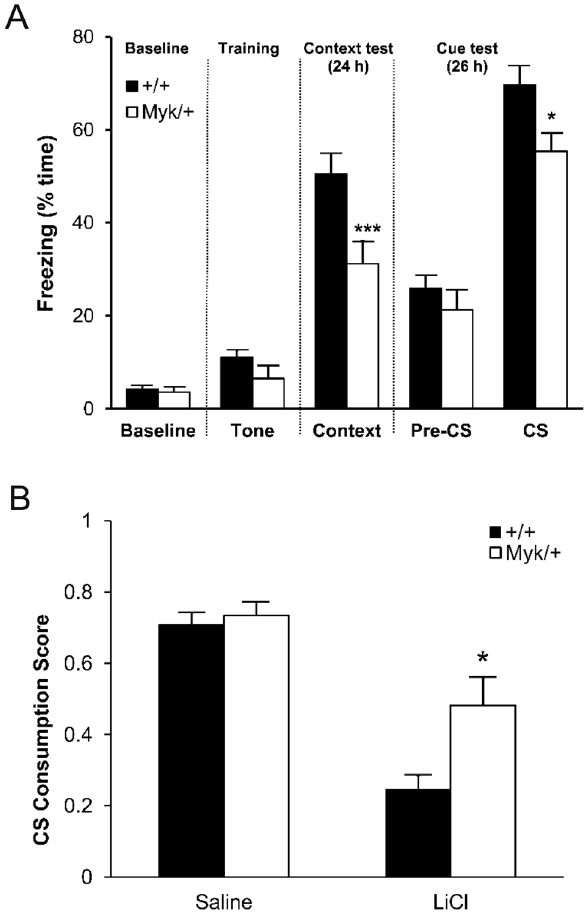
Figure 3. Cognitive impairment in Myk / + mice. (A) Fear conditioning with 1.0-mA footshock. Mean freezing levels ( 6 SEM) of Myk / + ( n= 24) and + / + ( n= 25) mice at baseline, during training, and in the contextual and cued conditioning tests. There were significant main effects of genotype on freezing in the context test ( F 1,48 =8.52, P= 0.005) and in the cue test during presentation of the auditory tone (CS; F 1,48 =6.20, P= 0.016). (B) Conditioned taste aversion. Mean ( 6 SEM) CS consumption scores (intake of saccharin/total fluid) 24 h following pairing with LiCl or saline treatment in Myk / + and + / + mice. There were significant main effects of genotype ( F 1,47 =6.51, P= 0.014), treatment ( F 1,47 =48.12, P= 0.0001), and genotype x treatment interaction ( F 1,47 =4.09, P= 0.049). * P , 0.05; *** P , 0.001; **** P , 0.0001 versus + / + mice.